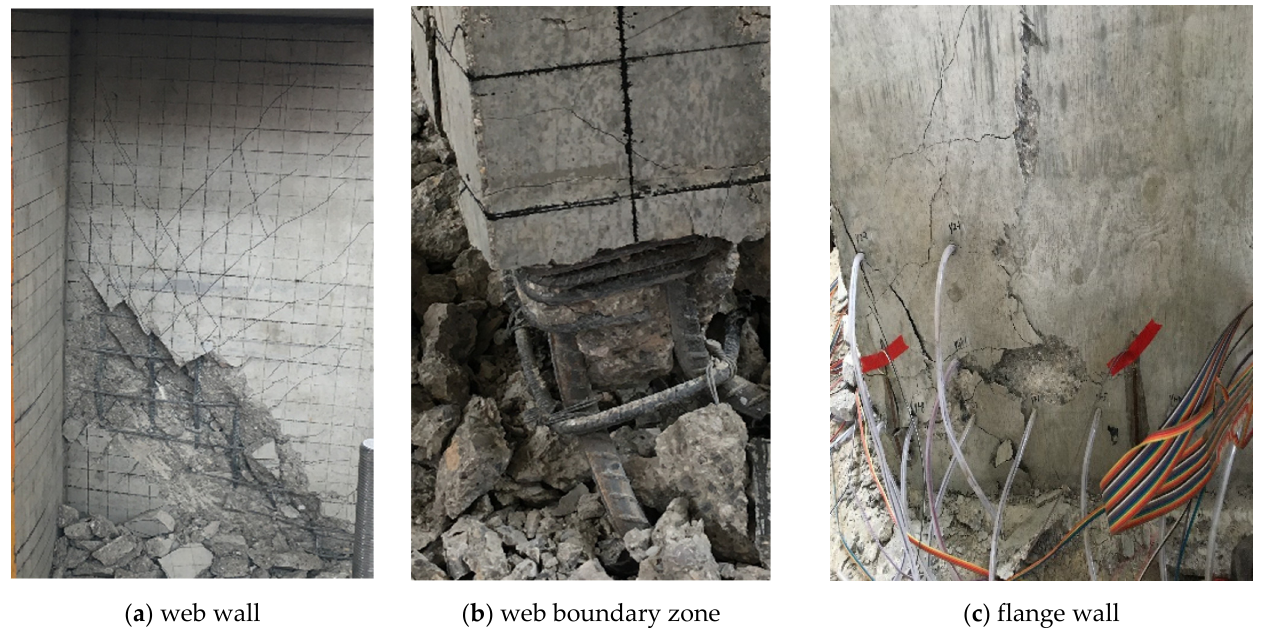
Figure 9. Crack patterns of HPLW800-1 at failure stage.